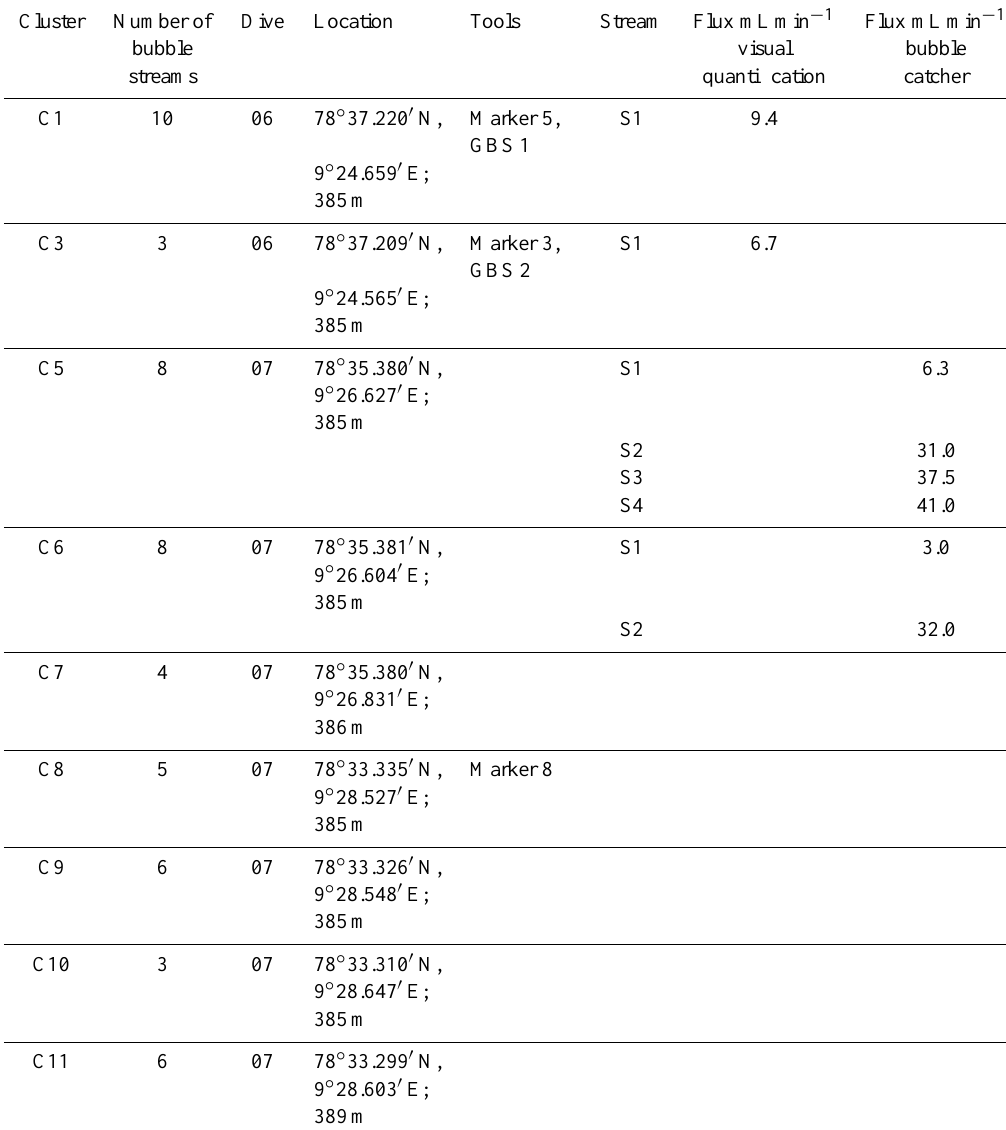
Table 5. Gas quantities transported by individual gas bubble streams in Area 3 (“396m flares”) determined by use of the bubble catcher and by interpretation of video